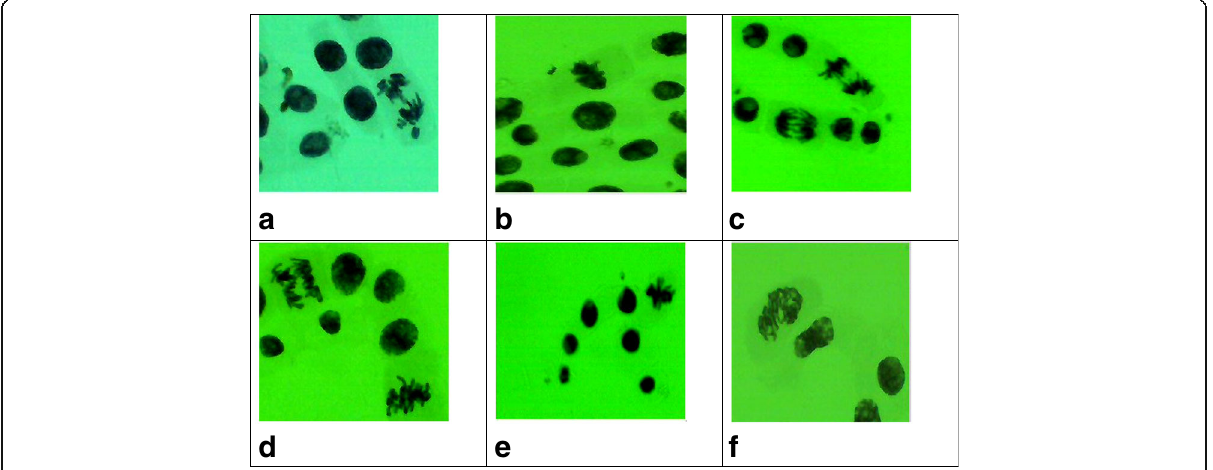
Fig. 1 a - c : Allium cepa root tip meristems after three hr of Moringa extracts. Micronucleus in resting cell and other split anaphase cell with structural bridge and a micronucleus after treatment with 10.0% Moringa extract ( a ), Sever sticky metaphase cell after treatment with 20.0% Moringa extract ( b ) and Two anaphase cells with partial stickiness and structural bridges after treatment with 10.0% Moringa extract ( c ). d - f : Allium cepa root tip meristems after three hr of bread yeast extracts. Two disturbed anaphases with structural bridges after treatment with 20.0% yeast extract ( d ), Severe sticky metaphase after treatment with 10 % yeast extract ( e ) and Disturbed prophase after treatment with 5.0%